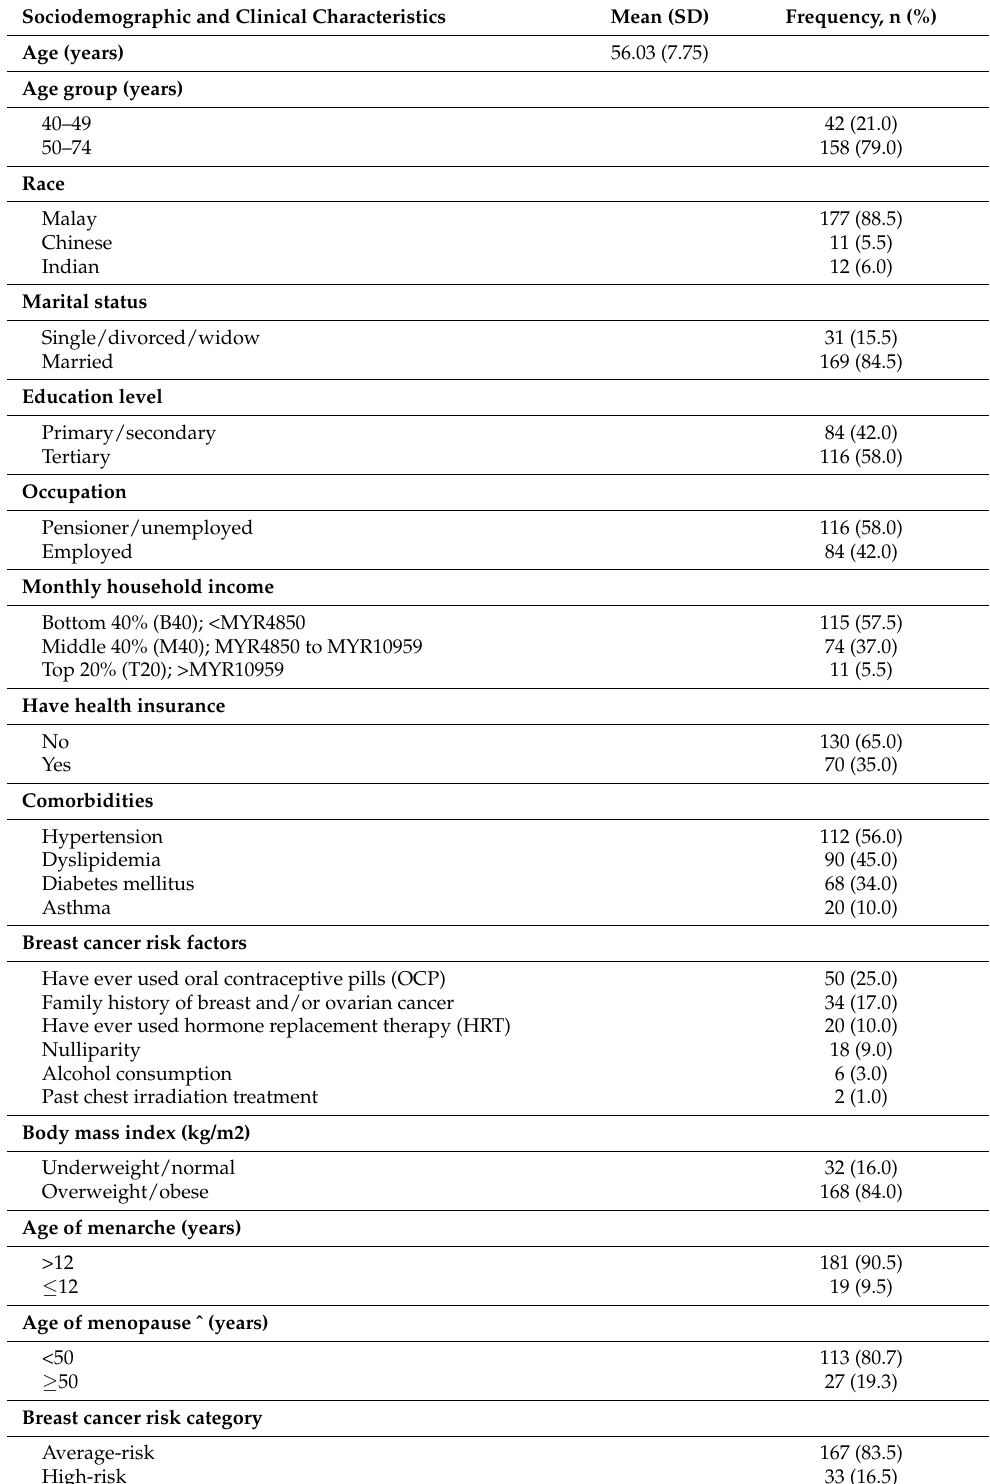
Table 1. Sociodemographic and clinical characteristics of the participants, n =